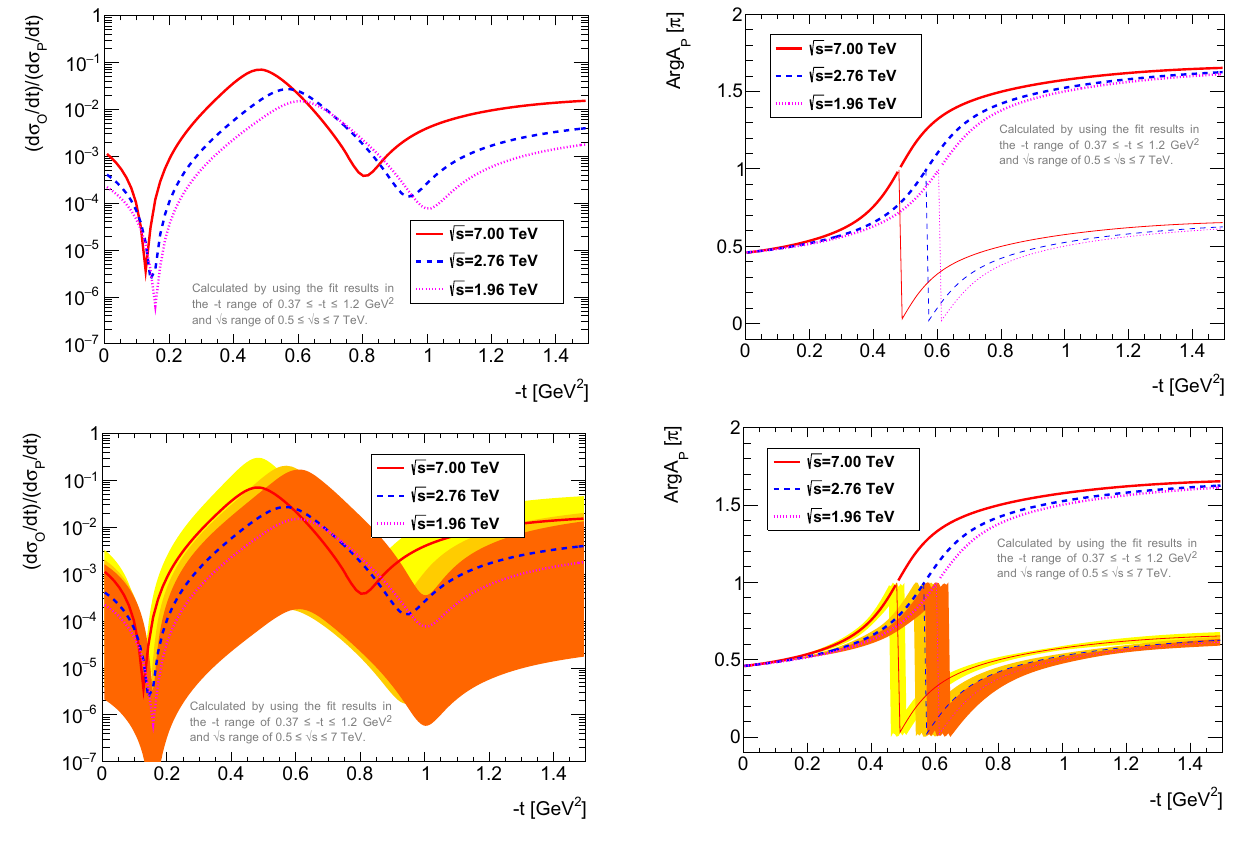
Fig. 23 Same as Fig. 21, but for the ratio of the differential cross- sections of Odderon to Pomeron exchange The top panel indicates the central values for the differential cross-section of Odderon exchange at various colliding ener- √ s in the TeV domain, while the lower panel includes gies our first estimates on the systematic errors of this reconstruc- tion, obtained by neglecting the possibly strong correlations between the parameters p 0 and p 1 . These figures also indi- diffractive minima, in contrast to the experimental results for the diffractive minimum in elastic pp collisions. How- ever, the interference between the Pomeron and the Odderon exchange leads to a single well defined and experimentally resolvable diffractive minimum in elastic pp collisions at the TeV scale. Figure 23 indicates the ratio of the differential cross- sections for Odderon to Pomeron exchange. This figure indi- cates that the Odderon contribution is important and rela- tively large in three kinematic regions: near to the t = 0 optical point, near to the position of the diffractive mini- mum of elastic pp collisions, t dip ≈ − 0 . 5 GeV 2 , and then at higher squared momentum transfer values, − t (cid:3) 1 GeV 2 . This figure also highlights with an explicit calculation, that the Odderon contribution to the dip region is correlated with